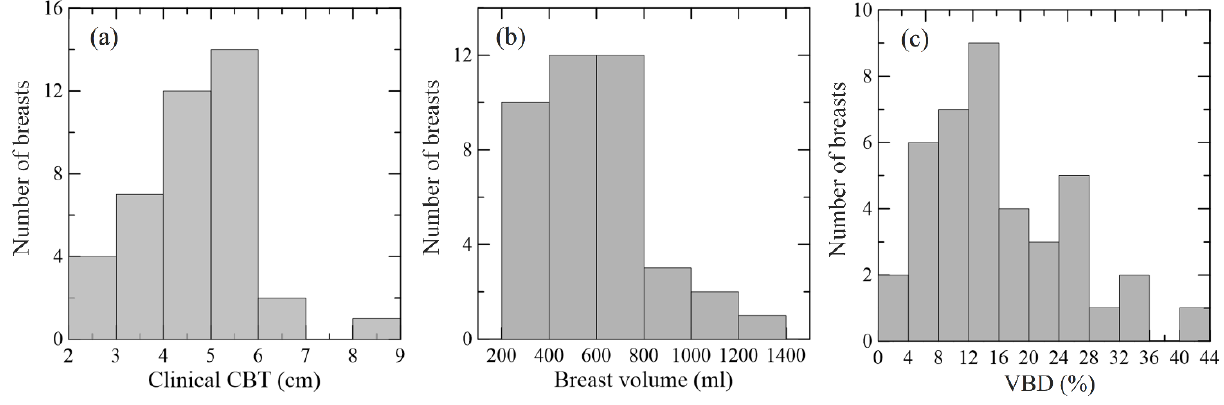
Figure 2. Distributions of ( a ) clinical CBT, ( b ) breast volume, and ( c ) VBD.